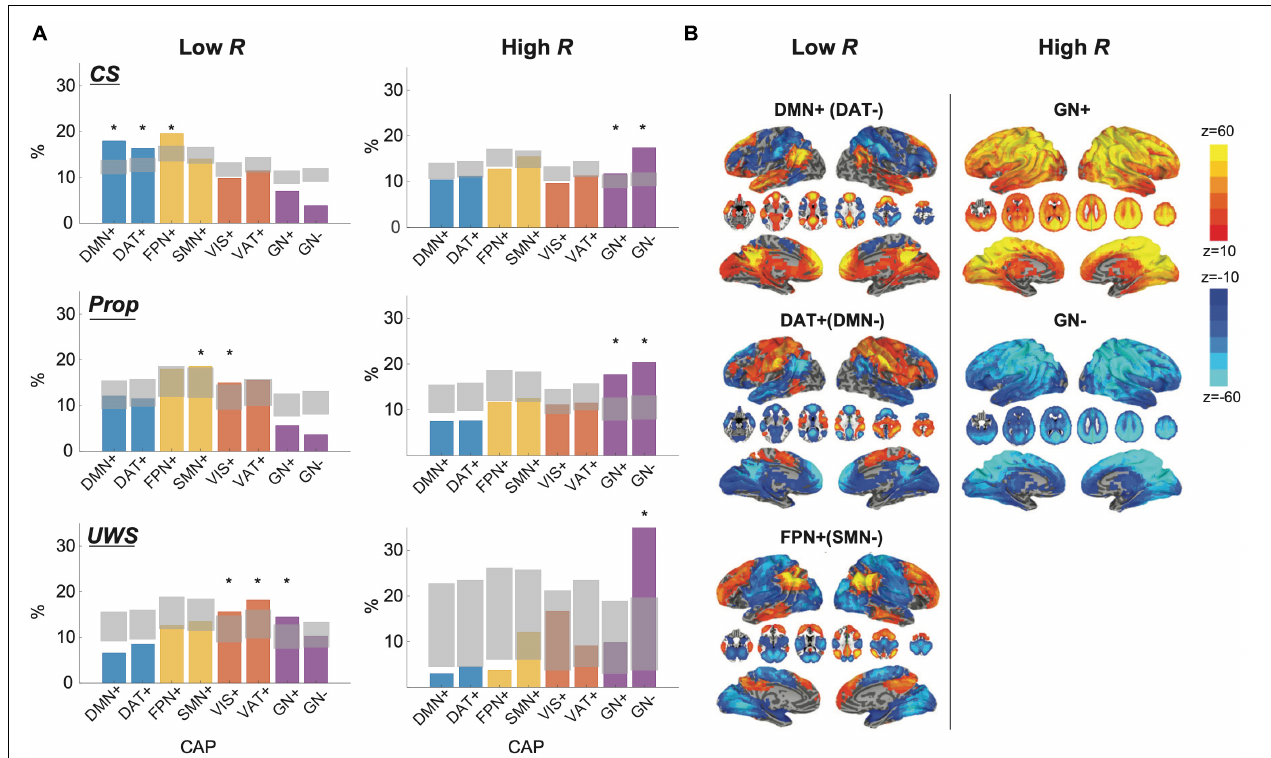
FIGURE 6 | Dominant fMRI co-activation patterns (CAPs) for low and high R windows in conscious states (CS), propofol-induced unconsciousness (Prop), and unresponsive wakefulness syndrome (UWS). (A) Occupancy percentages of CAPs in CS (1st row), Prop (2nd row), and UWS (3 rd row) for low R (left) and high R (right) windows. Gray areas indicate quantiles ranging from 0.5% to 99.5% from the distributions of 20000 permutation sets. Significantly dominant CAPs are marked as ‘*’ in the figure. The CAPs consist of eight different functional networks such as a default-mode network (DMN+), dorsal attention network (DAT+), frontoparietal network (FPN+), sensory and motor network (SMN+), visual network (VIS+), ventral attention network (VAT+), and a global network of activation and deactivation (GN+ and GN − ). Functional networks including DMN+(DAT − ), DAT+(DMN − ), and FPN+(SMN − ) are dominant in low R windows, while functional networks including GN+ and GN- are dominant in high R windows in CS. (B) Spatial maps of CAPs for low and high R windows in CS. Spatial maps of other CAPs are presented in the Supplementary Figure 7